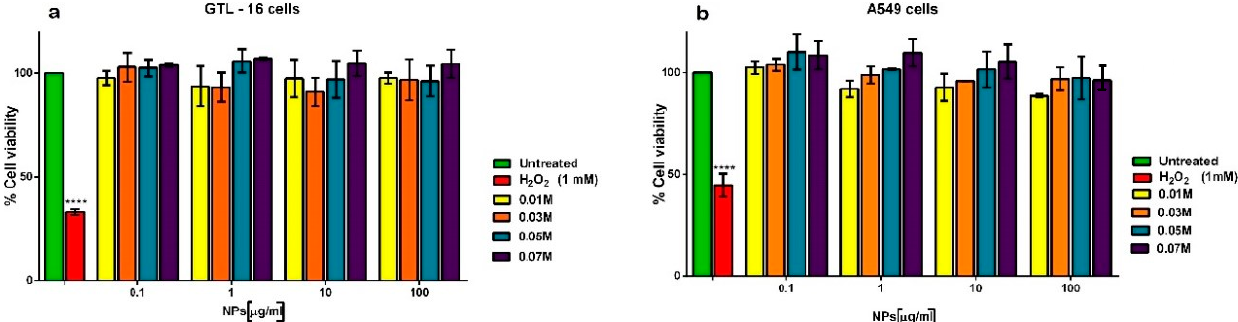
Figure 7. Luminescence properties of cit-Ca 2+ :TbPO 4 · nH 2 O dispersed in aqueous media with x = 0.01 M Ca 2+ , 96 h maturation time and 25 °C versus pH; ( a ) Excitation (dashed line) and emission (solid line) spectra; ( b ) Variation of R.L.I. versus pH; ( c ) Luminescence decay curve; and ( d ) Variation of luminescence lifetime with the pH.